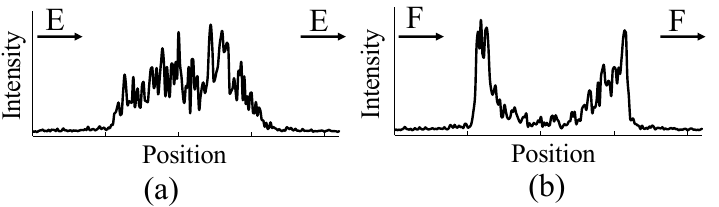
Figure 9. Section of intensity. ( a ) Two light sources with phase difference 0 rad. ( b ) Two light sources with phase difference π rad.